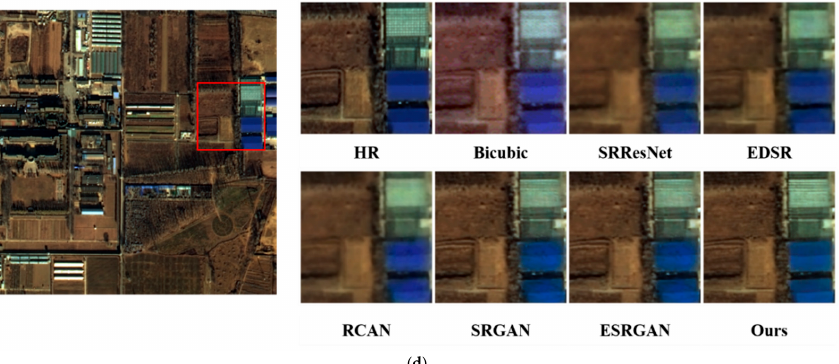
Figure 9. Visual comparison of some representative SR methods and the proposed model, the figure on the right is an enlargement of the area in red on the left: ( a ) road; ( b ) container; ( c ) residential buildings; ( d ) factory.